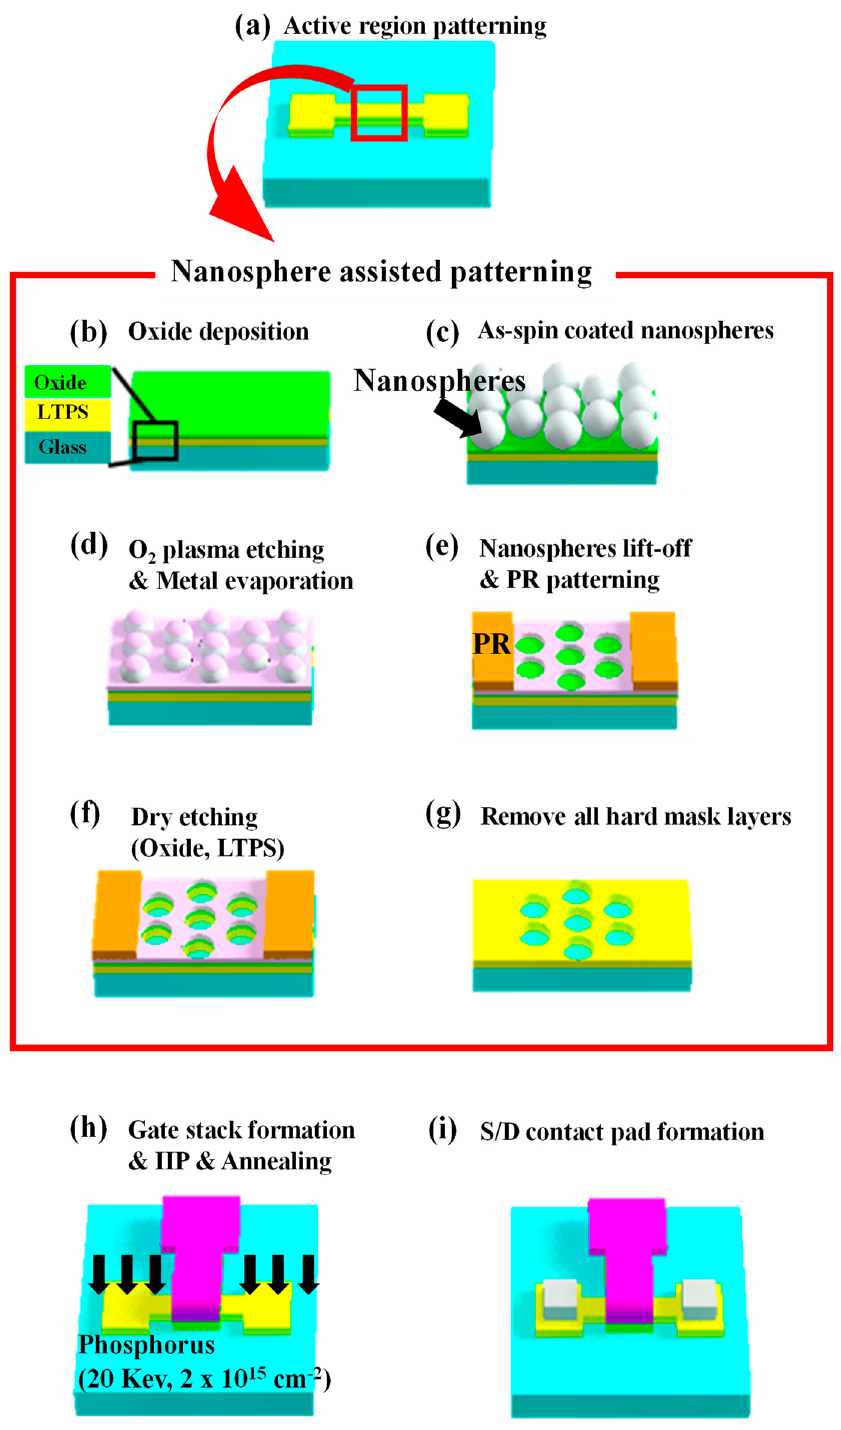
Figure 1. Schematic diagram of fabrication steps of nanonet-channel thin-film transistors (TFTs) using the nanosphere-assisted patterning (NAP) technique.